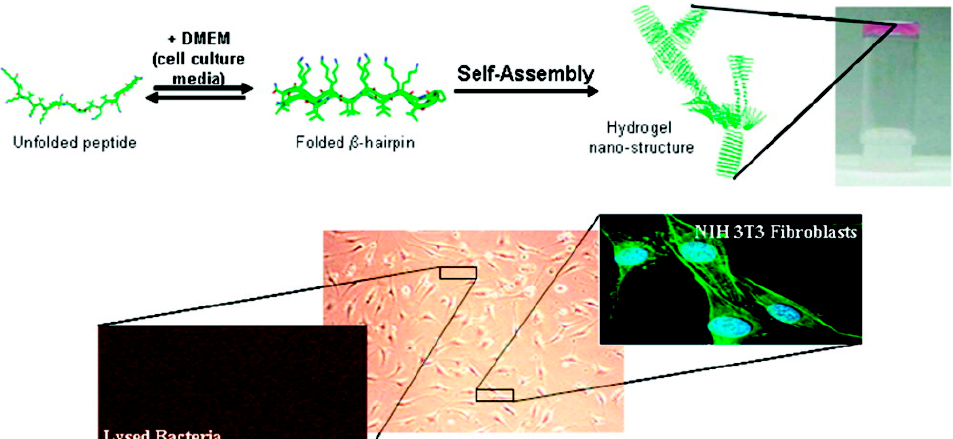
Figure 9. MAX1 hydrogelation mechanism and targeted antibacterial activity in co-culture. Adapted with permission from [124]. Copyright 2007 American Chemical Society.